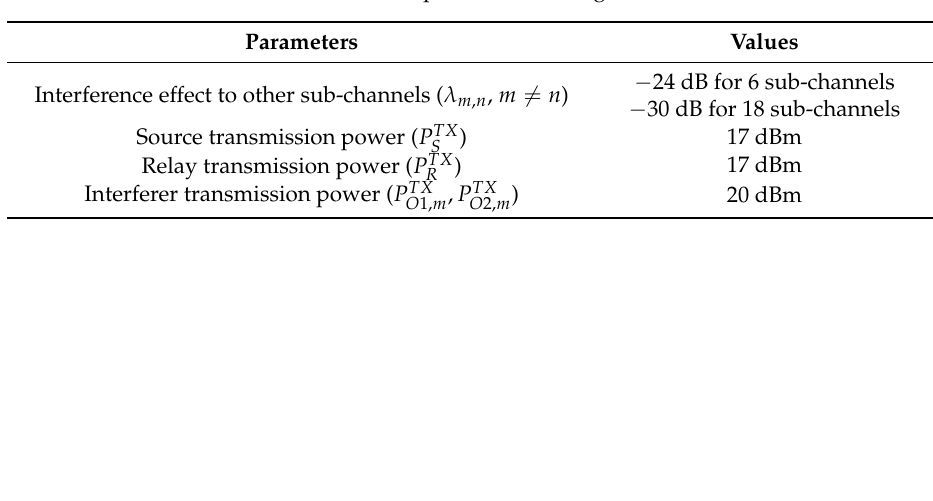
Table 2. Simulation parameters for Figures